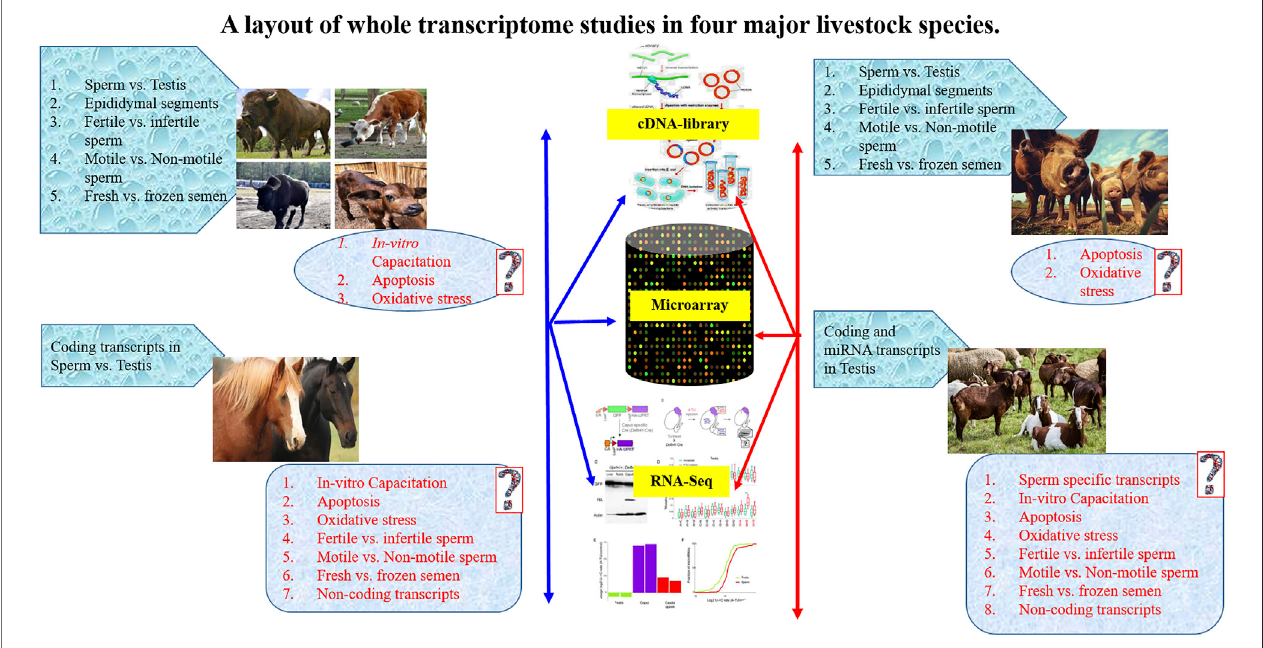
FIGURE 1 | A layout of whole transcriptome studies in four major livestock